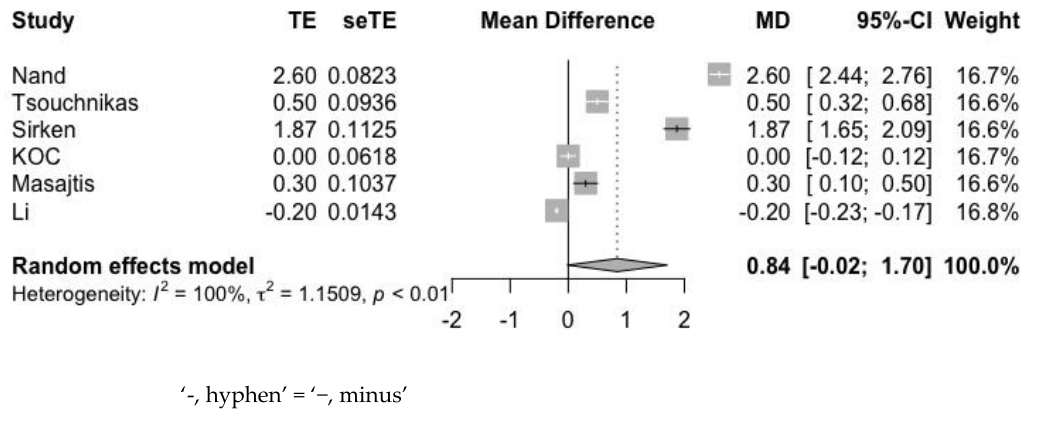
Figure 7. Mean difference of Hb between baseline and endpoint of study group solely.